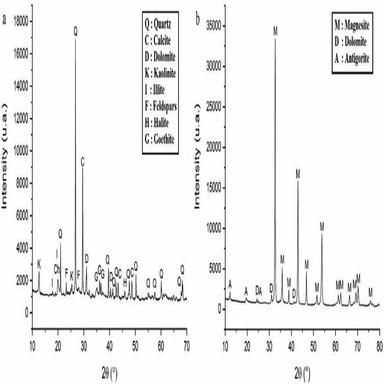
X-ray diffraction of the selected geomaterials in this study: (a): Marl; (b): Magnesite.